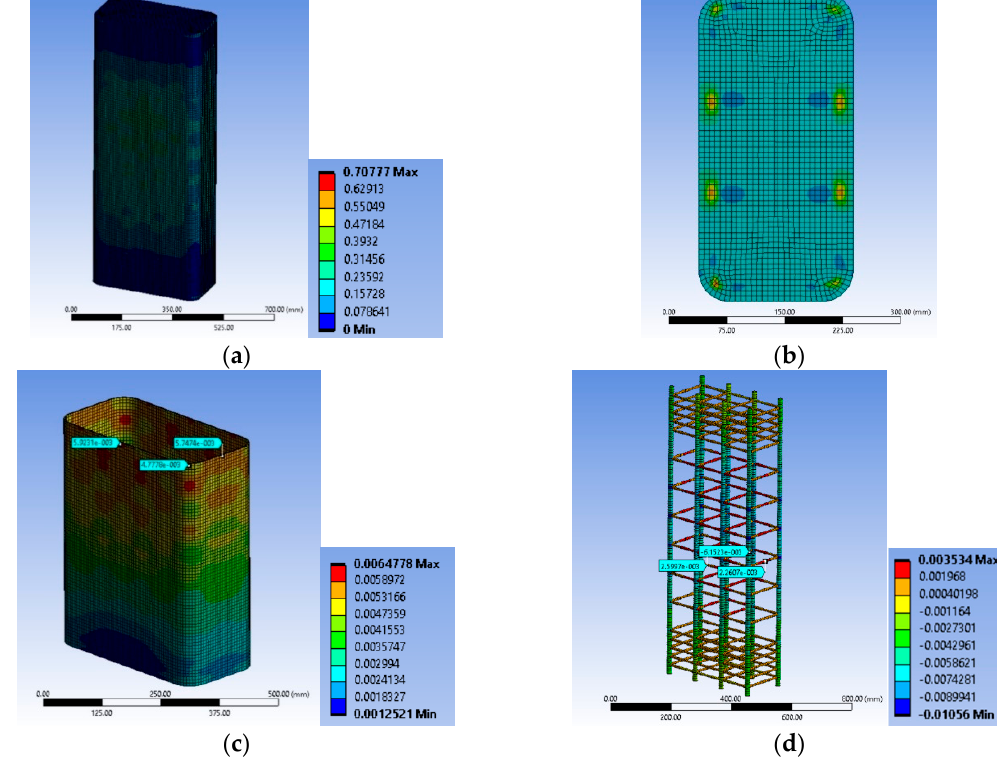
Figure 15. Variation of concrete damage for specimen ( a ) at the ultimate condition; ( b ) at the level of the stirrup; ( c ) CFRP strain and characteristic values at the ultimate condition at the level of the stirrup and ( d ) ε stirrup_max , ε long_mid and ε long_min for specimen